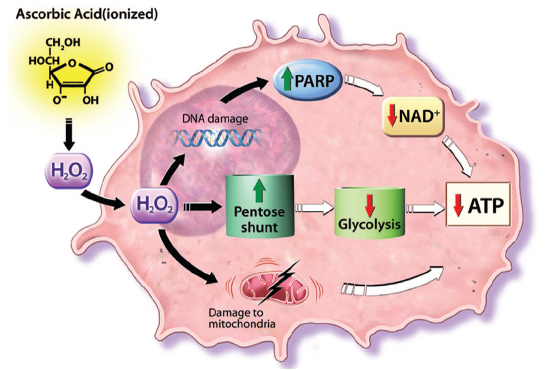
Figure 3. Hydrogen peroxide ‐ dependent cytotoxic effects after ascorbate exposure, according to